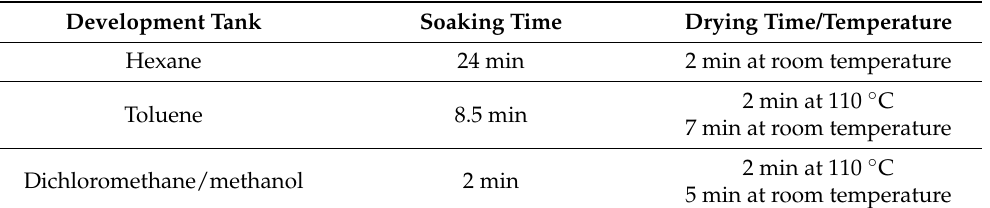
Table 4. Iatroscan soaking and drying